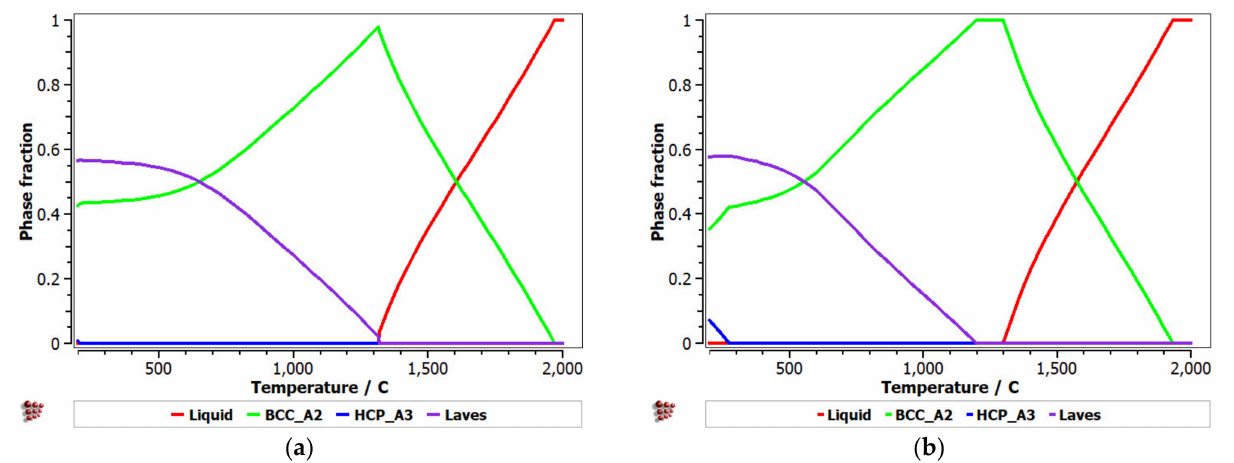
Figure 5. Equilibrium diagrams for the ( a ) FeTa 0.5 Nb 0.5 TiZr 0.5 and ( b ) FeTa 0.5 Nb 0.5 Ti 1.5 Zr 0.5 alloys. The equilibrium diagram of the FeMnNb 0.5 TiZr 0.5 (Figure 7) indicates the high stability of the solid solution, based on a BCC–A2 structure. At low temperatures, the Laves intermetallic phases had high contents, which determined a complex multiphase structure with low percentages of the HCP–A3 and Beta–Mn